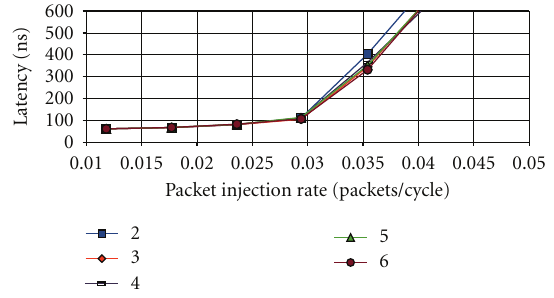
Figure 8: Latency as number of virtual channels is varied for apte .